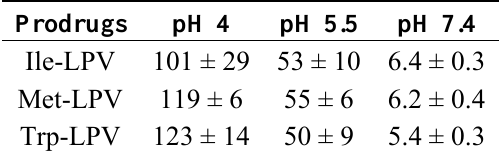
Table 1. Degradation half lives (h) of prodrugs at various pH values.